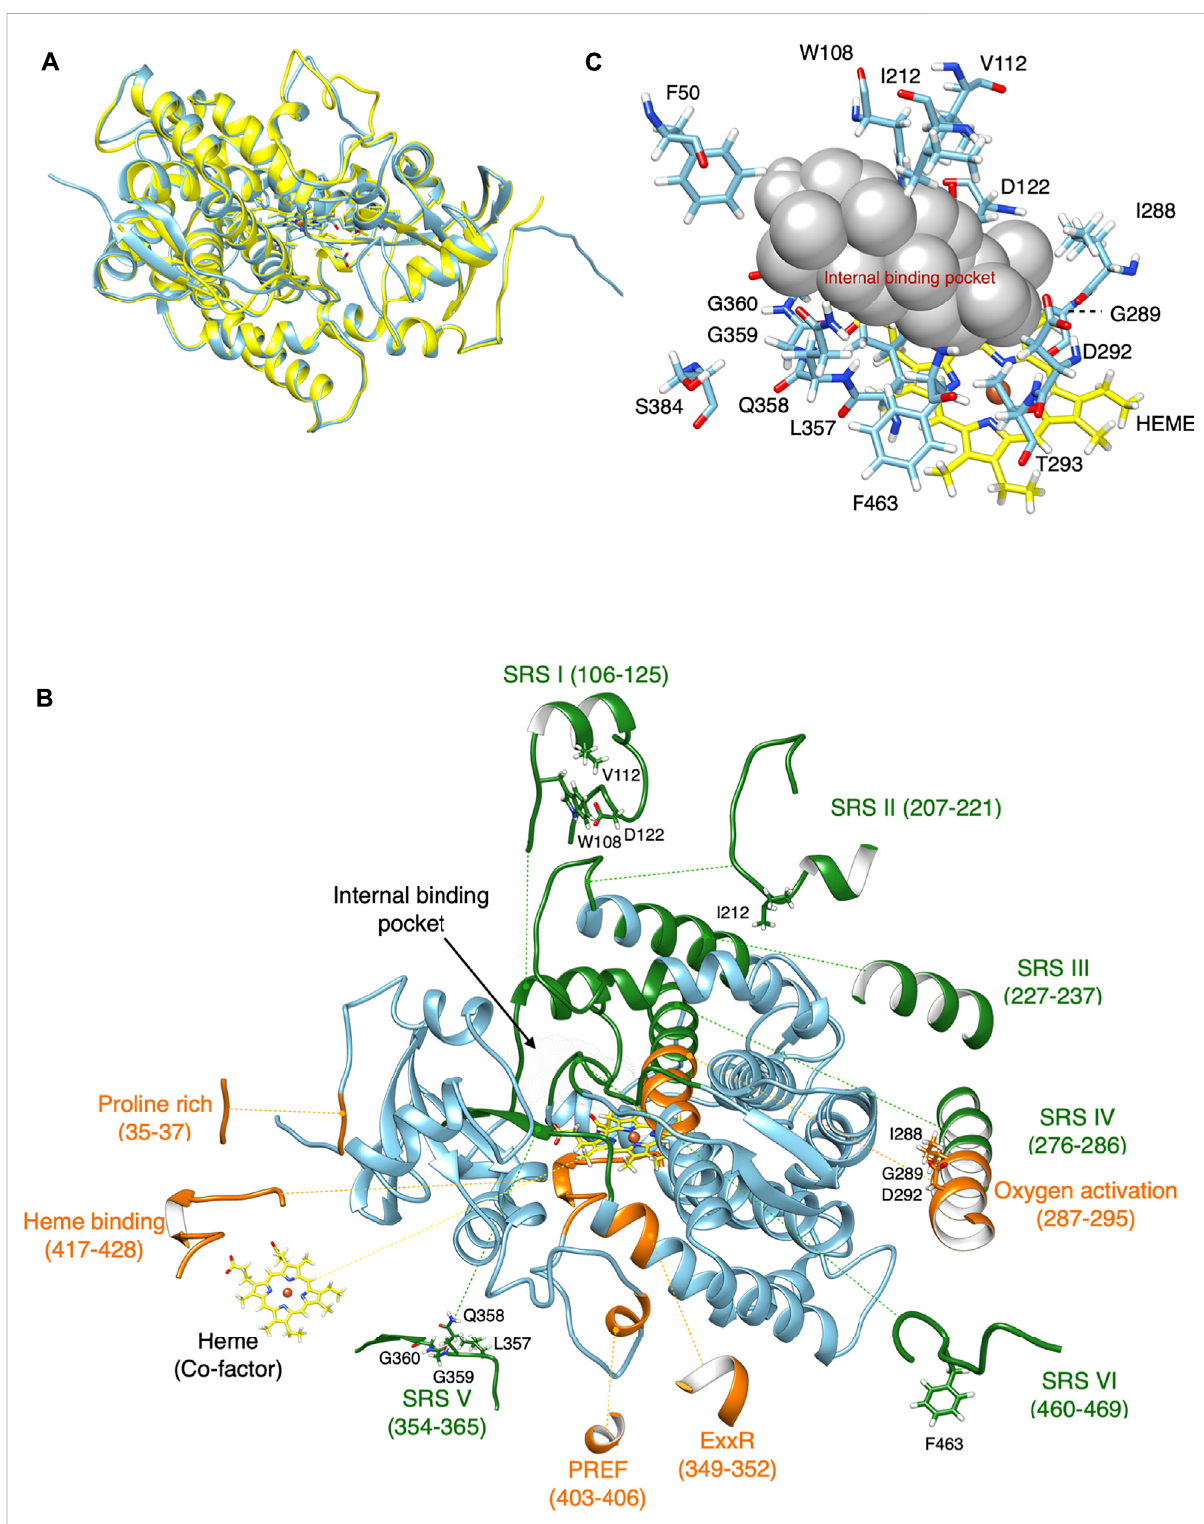
FIGURE 1 Comparative homologymodelingofCYP716A12. (A) TheretinoicacidboundcyanobacterialCYP120A1(2VE3_A)chainAisthehighestmodelin thesimilarityoftheexperimentalstructure.Itwasselectedasatemplatemodel(Yellow)andhomologystructureofCYP716A12(blue). (B) Homology modeling ofCYP716A12with apredictedligand-binding siteareafor molecular dockinganalysis.Substraterecognitionsites(SRS),(green), Signature region (orange). This homology model exceeded the quality criteria veri fi ed by VERIFY3D by 89.24%. (C) The spatial positions of 15 (15 of 479) candidate amino acid residues were putatively involved in the catalytic activity of the CYP716A12 enzyme in the area of the ligand-binding site via a molecular docking analysis and the I-TASSER